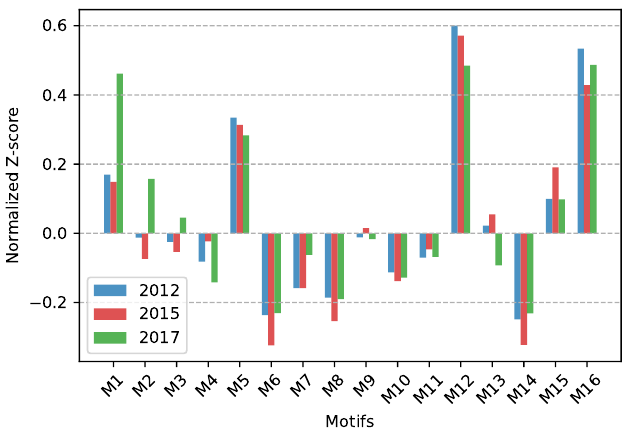
Figure 9. The TSP in